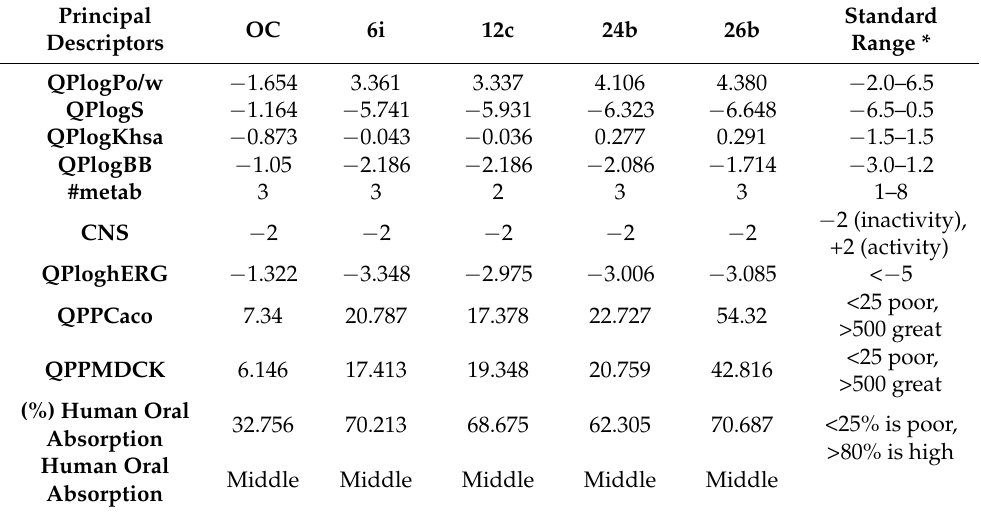
Table 3. Comparison of computational pharmacokinetic parameters (ADME) of OC